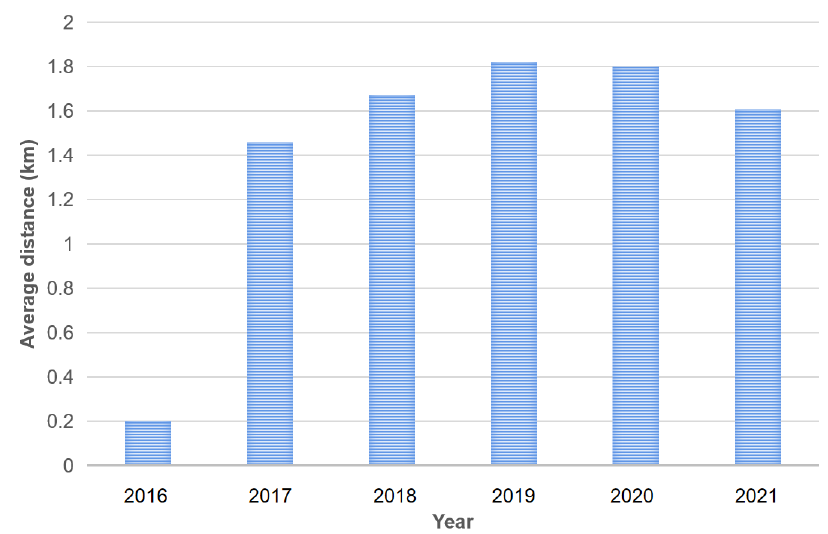
Figure 5. Average travel distance from 2016–2021.